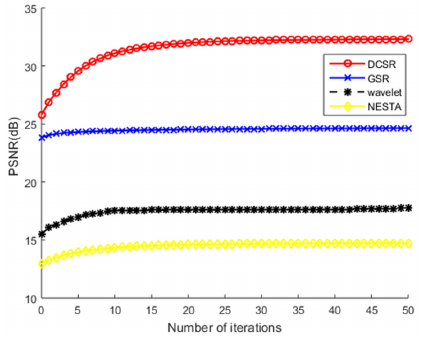
Figure 11. PSNR values of Barbara’s grayscale image recovered by four competing methods as a function of the number of iterations. The test image is corrupted by AWGN.